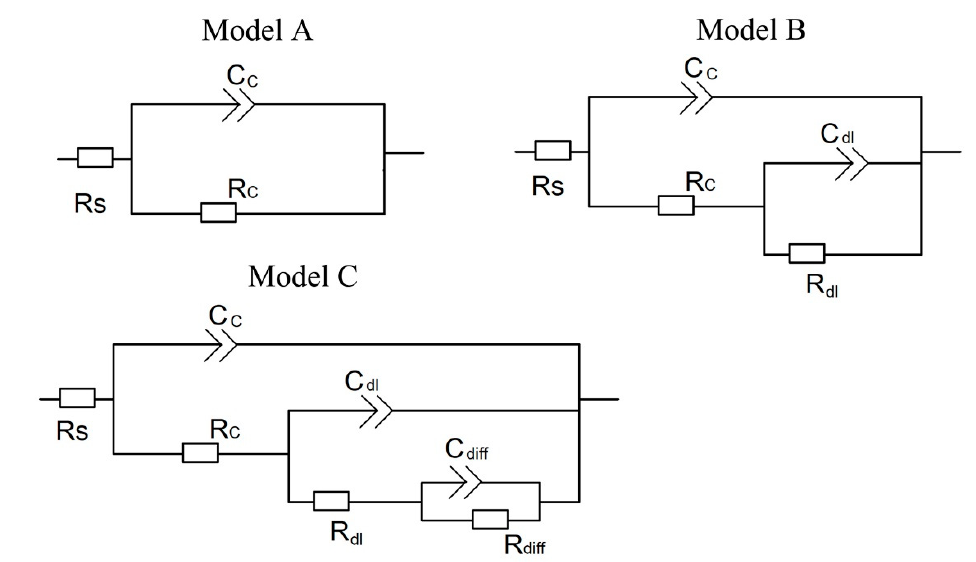
Figure 4. Equivalent electrical circuits used for numeric fitting of EIS data.